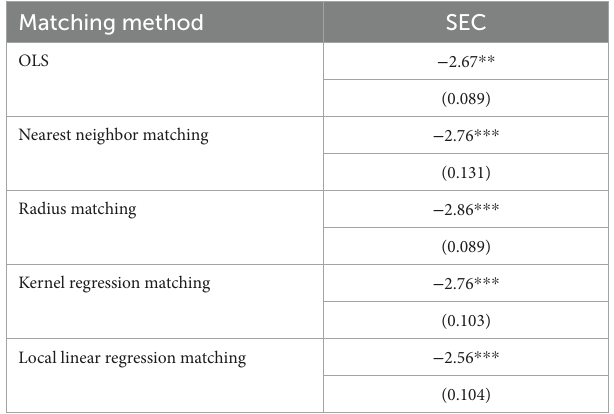
TABLE 7 Processing effect of family background on left-behind children’s SEC (ATT).